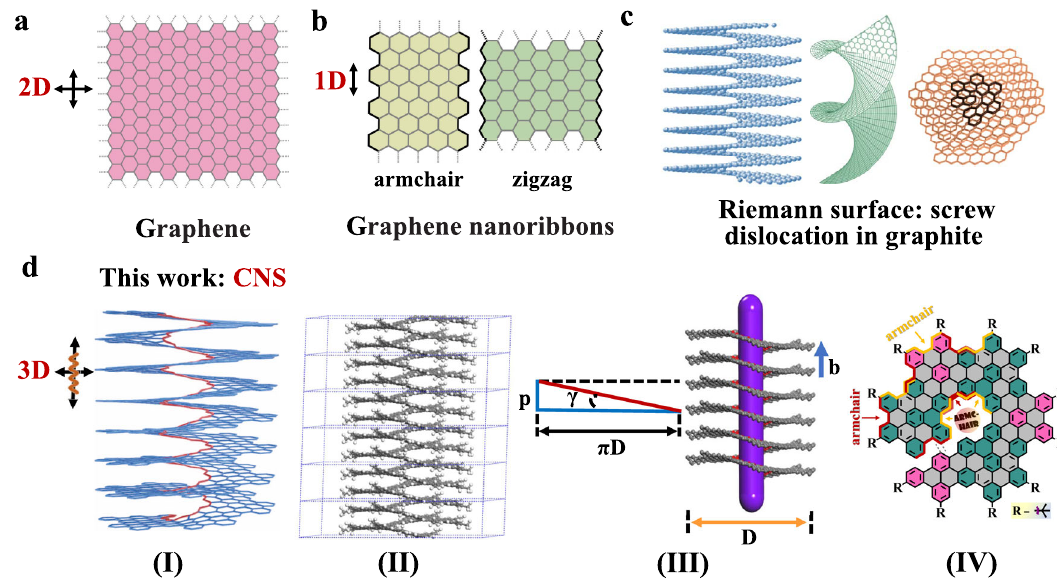
Fig. 1 Schematic illustrations of known or predicted carbon allotropes. a 2D extended graphene, the thinnest sp 2 allotrope of carbon arranged in a honeycomb lattice. b 1D graphene nanoribbons with armchair edges (AGNRs) and zigzag edges (ZGNRs). c Examples of the predicted structure of helically twisted graphenes with Riemann surface. d (I) Design of the 3D fully π -extended curved single-stranded carbon nanosolenoids (CNS) 25 . (II) The atomic structure of CNS with side view by the DFT calculations. (III) Helical structure of CNS without the alkyl substituent groups. Burgers vector b parallel to the c -axis (purple). D , p , and γ are the outer diameter, pitch, and coil angle, respectively. (IV) Edges and helical core structures of CNS. Fig. 1c (left) adapted with permission from ref. 25 (copyright 2016 American Chemical Society), Fig. 1c (middle) adapted with permission from ref. 66 (copyright 2019 American Physical Society), and Fig. 1c (right) adapted with permission from ref. 67 (copyright 2018 American Chemical